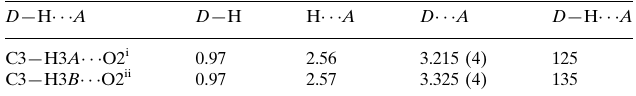
Hydrogen-bond geometry (A˚ , (cid:2)